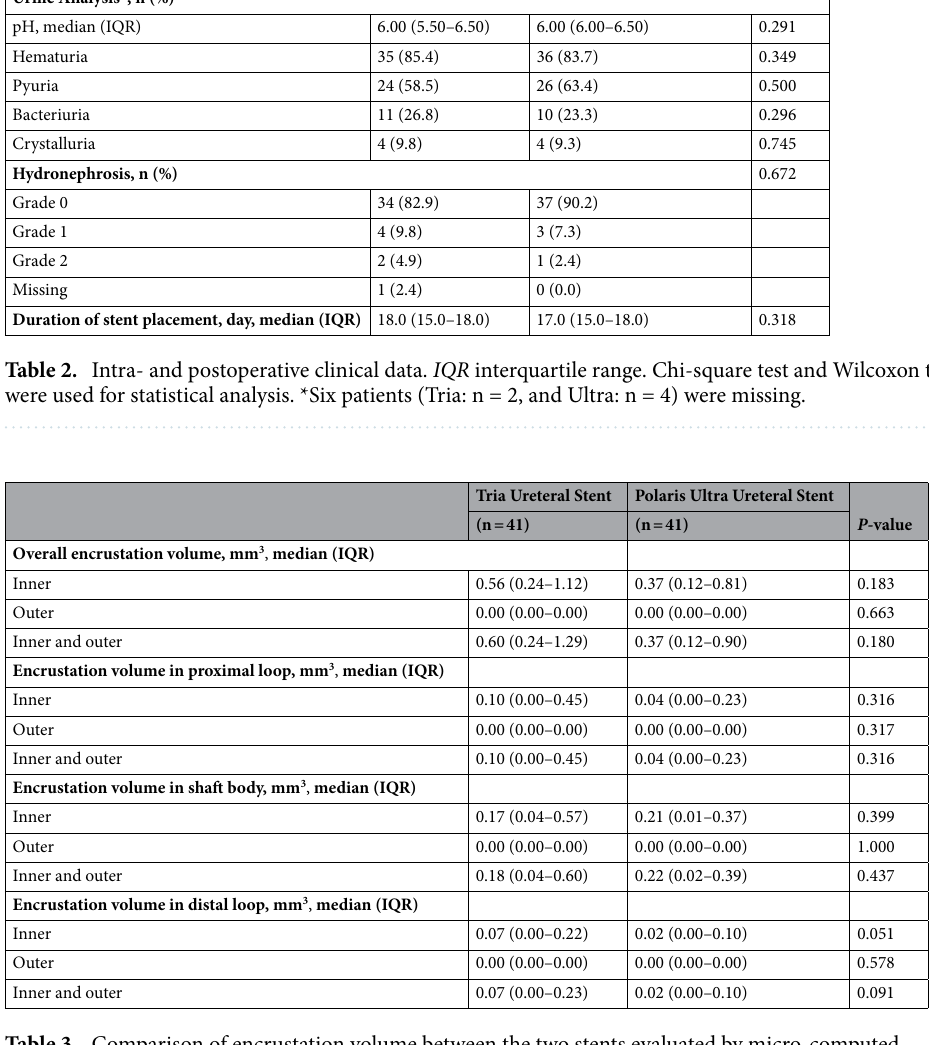
Table 3. Comparison of encrustation volume between the two stents evaluated by micro-computed tomography. IQR interquartile range. Chi-square test and Wilcoxon test were used for statistical analysis.